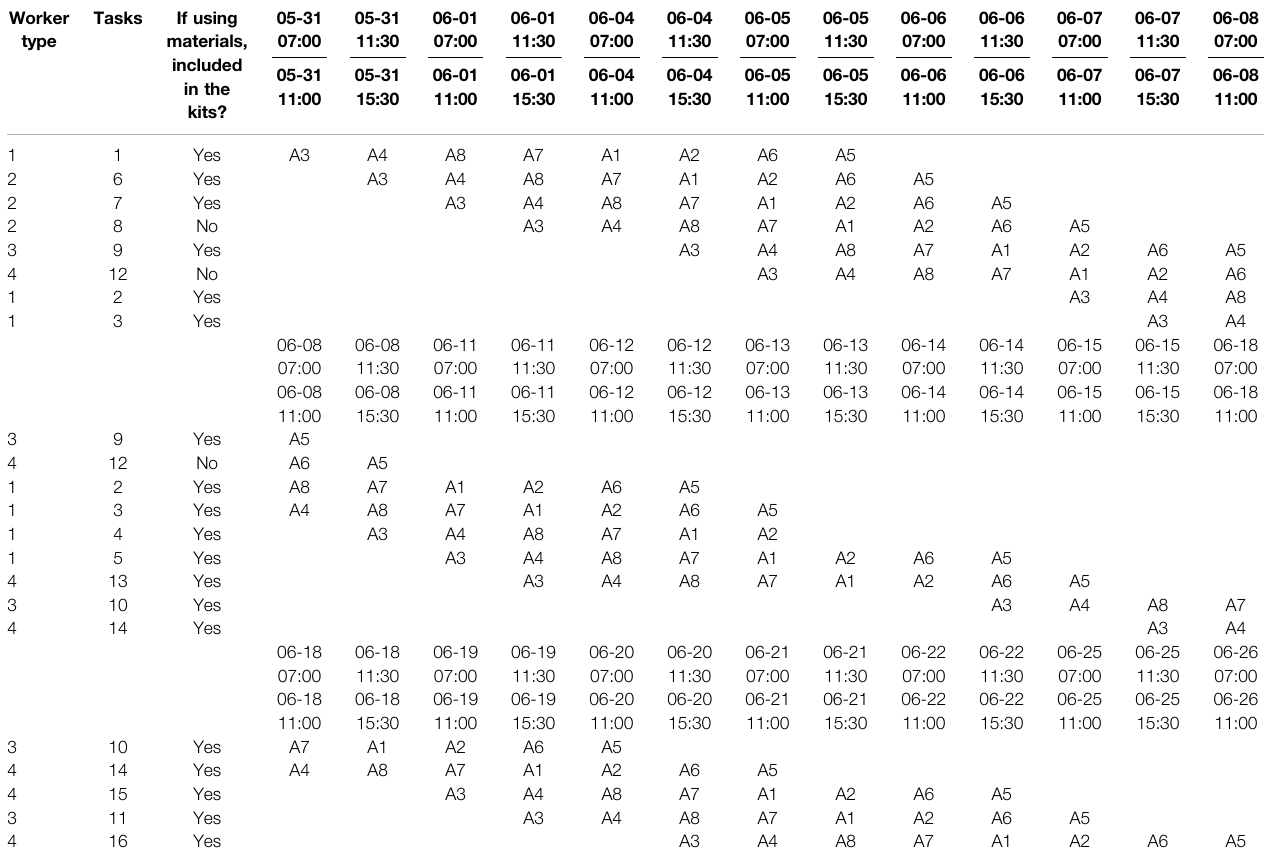
TABLE 2 | Task schedule summary for tracked workers and tasks. Worker Tasks If using type materials,